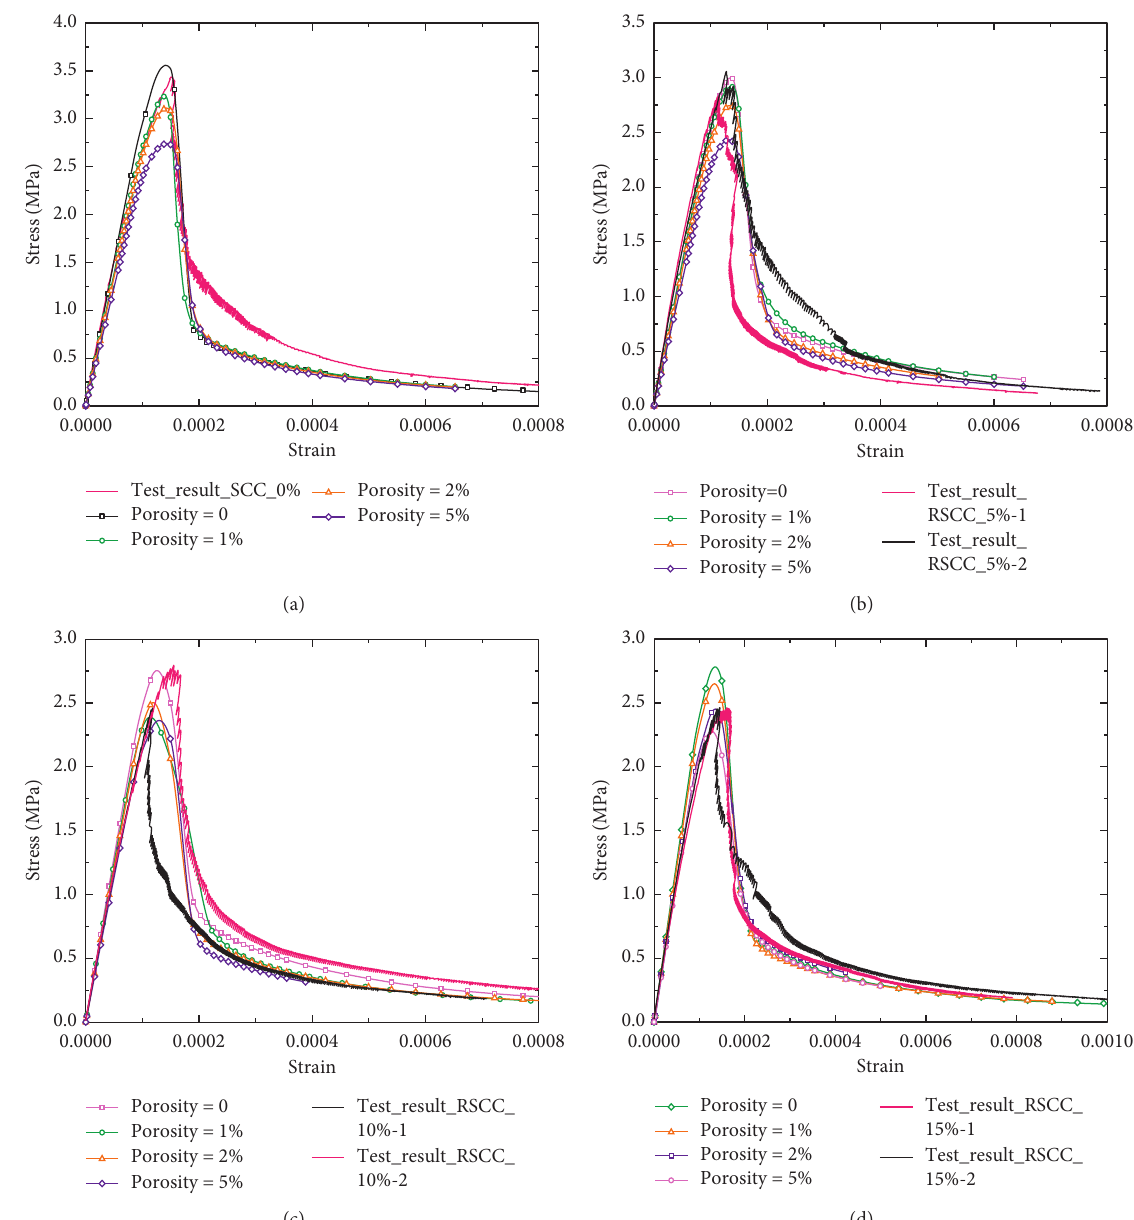
Figure 13: Stress-strain curves of varying porosity models. (a) Specimen with no rubber. (b) Specimen with 5% rubber. (c) Specimen with 10% rubber. (d) Specimen with 15%